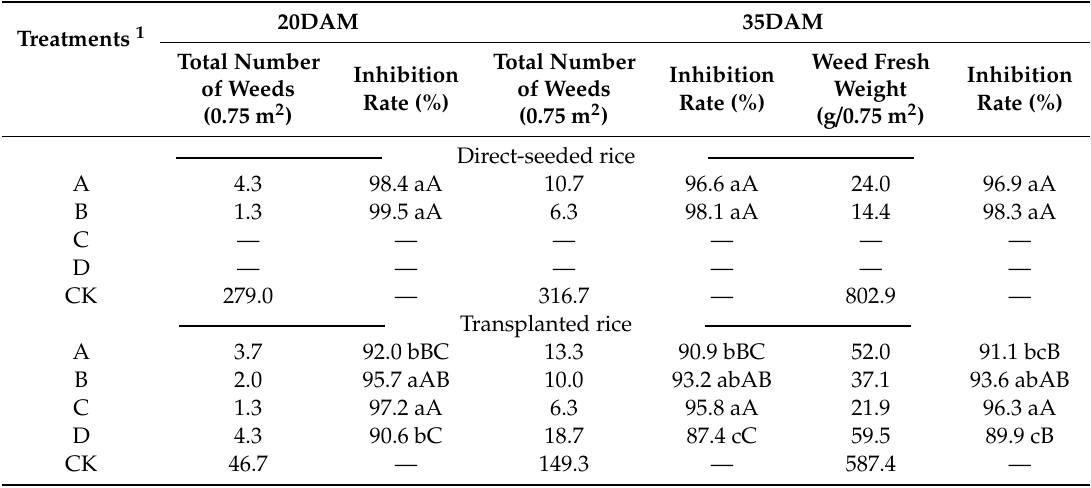
Table 6. E ff ects of various oilseed rape straw mulch treatments and herbicide application on the density and fresh biomass of weeds in direct-seeded and transplanted rice field